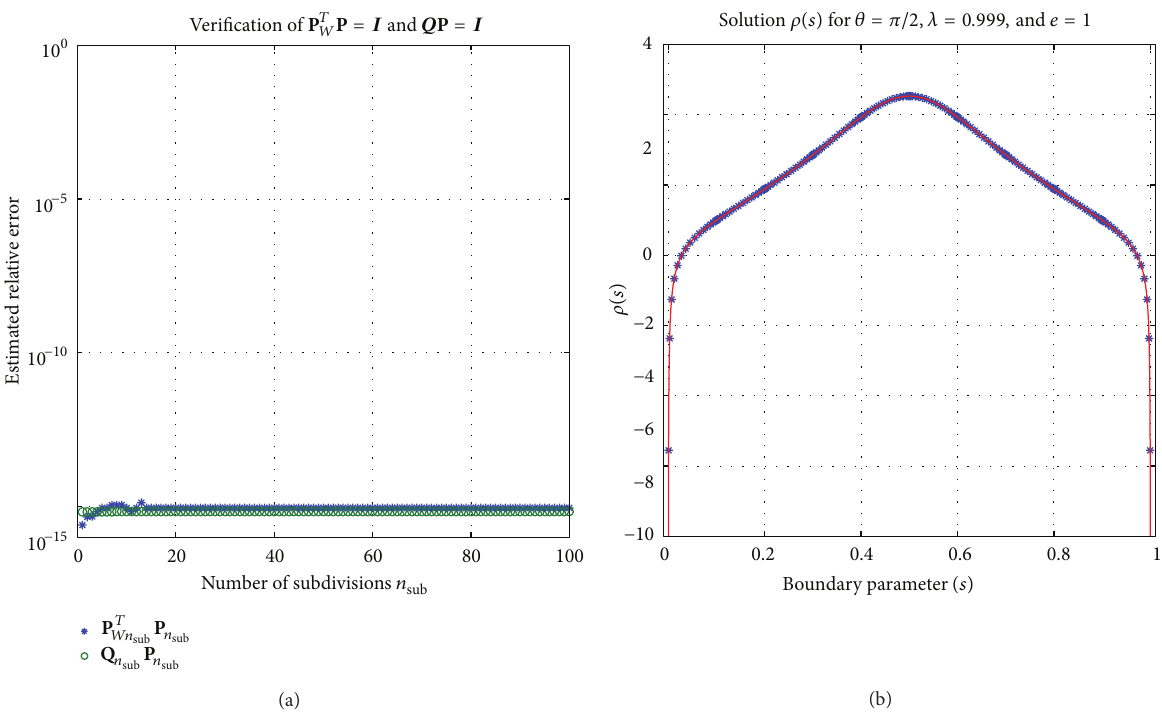
Figure 9: (a) The identities (14) and (31) hold to high accuracy in our implementation, irrespective of the degree of mesh refinement. (b) The solution 𝜌 to (25) on (1) with parameters as specified in Section 4. The solution with RCIP (17) and (28), shown as blue stars, agrees with the solution from (8), shown as a red solid line. The solution diverges in the